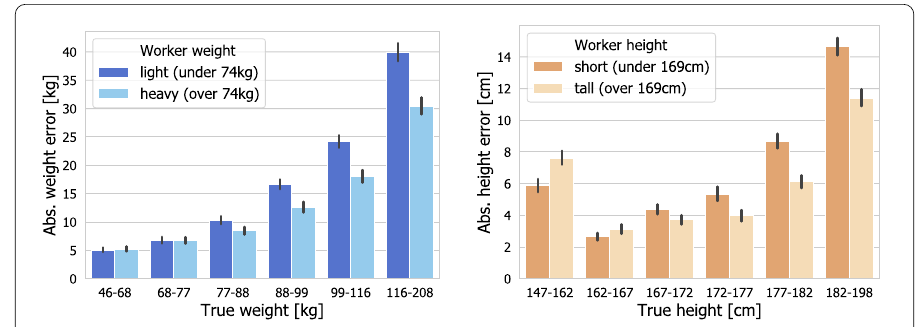
Figure 15 Dependence of weight/height mean absolute error (MAE) of guesses on true weight/height of the person in the image ( x -axis) and worker’s